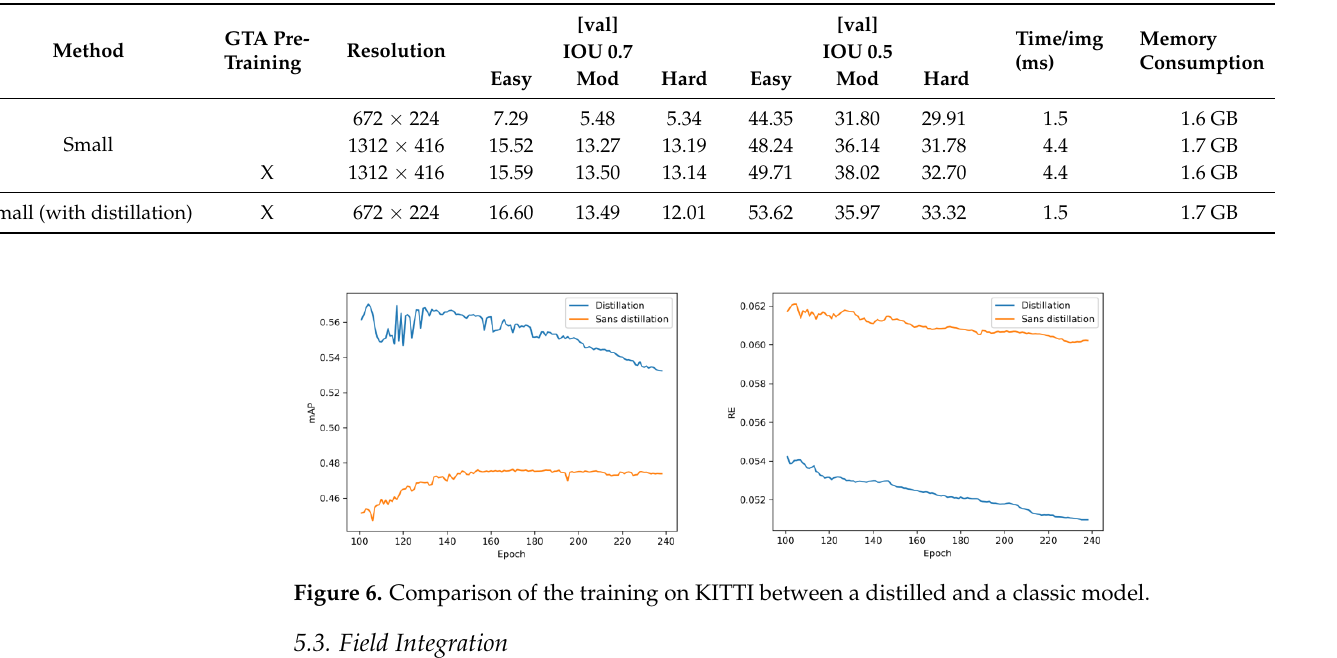
Table 5. Comparison between a distilled model with a regular model, on the KITTI dataset, on a RTX 3080 GPU.